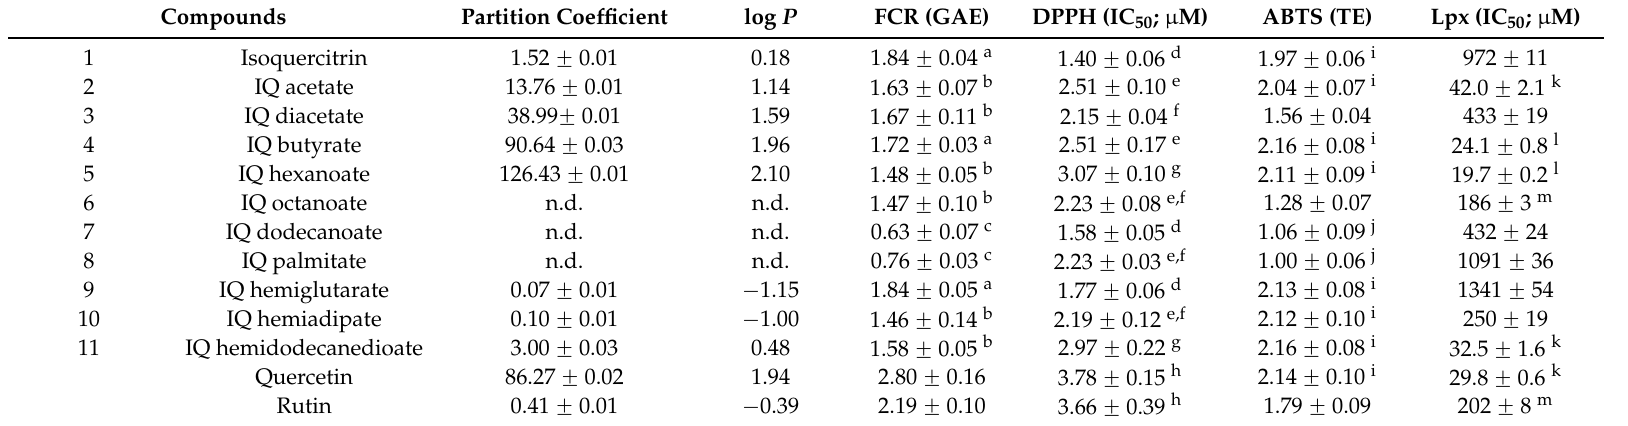
Table 1. Log P values, radical scavenging and anti-lipoperoxidant activity of isoquercitrin, compounds 2 – 11 and